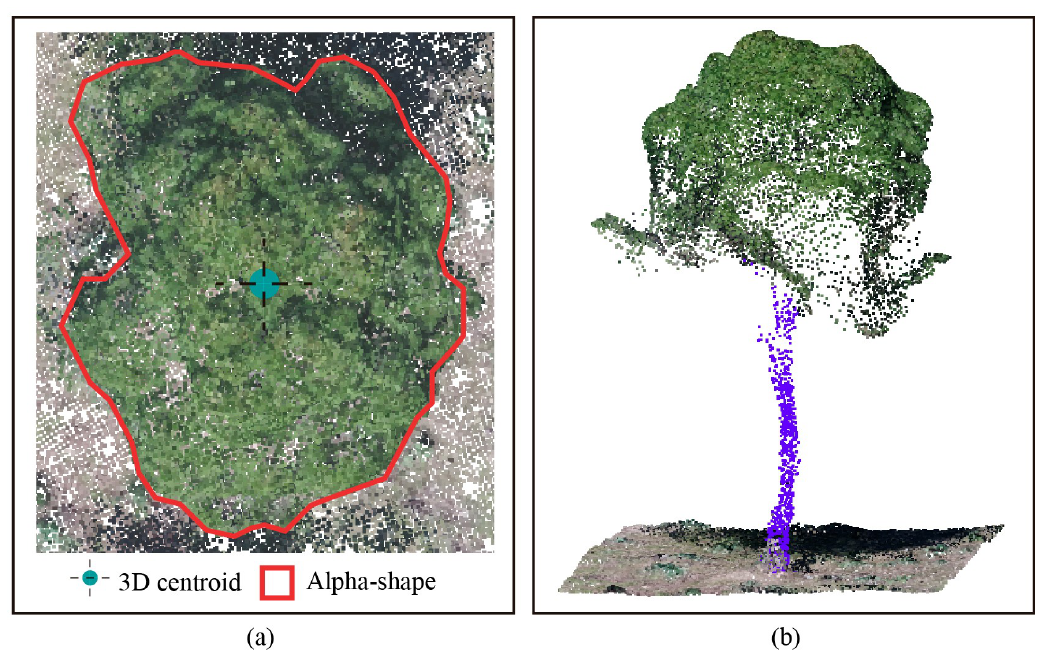
Figure 7. The segmentation of the tree trunk. ( a ) The top view of the alpha-shape and centroid on the tree crown; and ( b ) The points labeled as the tree